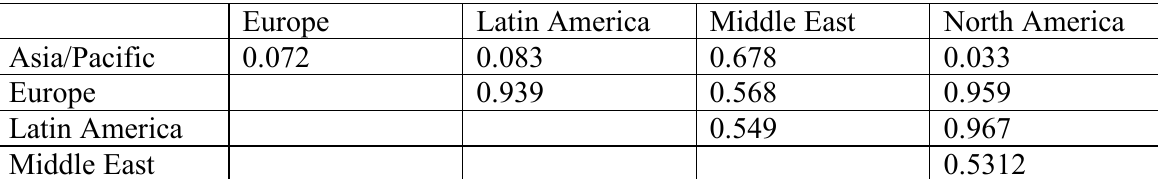
Table A3.6. GLMM model results for pairwise comparisons examining differences in ornamental plant richness based on region of national origin of gardeners. Numbers show p- values for pairwise comparisons of different levels for reach